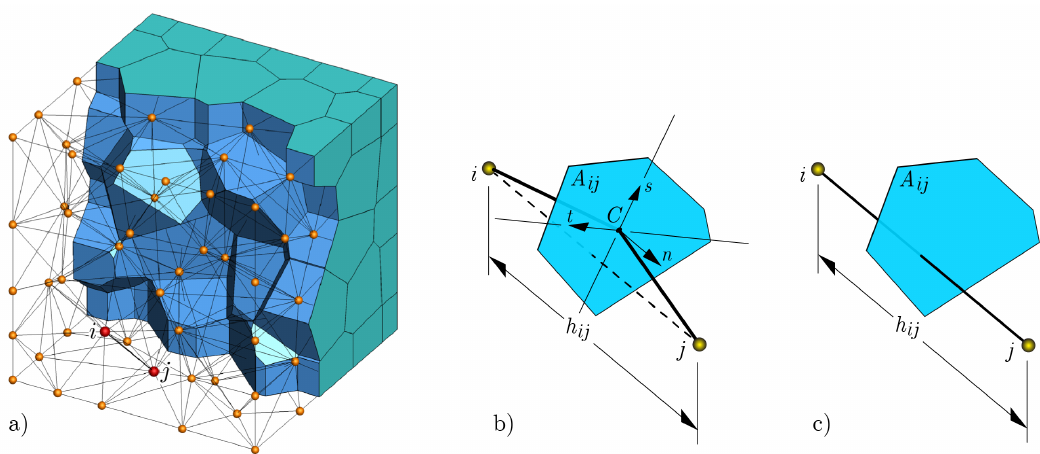
Figure 1. Lattice model: ( a ) domain discretization based on Delaunay and Voronoi tessellations; ( b ) mechanical lattice element ij based on the rigid-body-spring concept; and ( c ) conductive lattice element ij